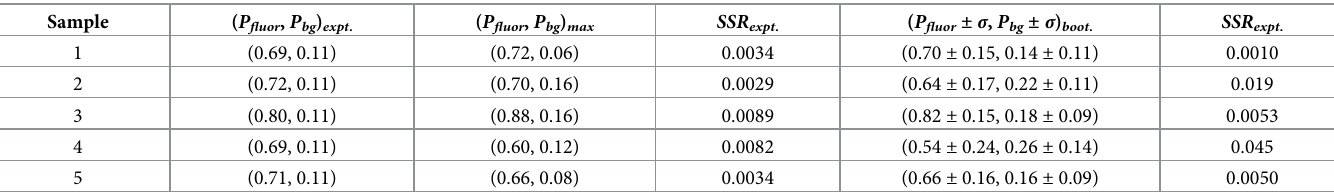
Table 3. Fitted vs. experimental parameters for RCLC samples 1–5, and χ rec . = 2 x 10 − 9 to 2 x 10 − 6 . Sample